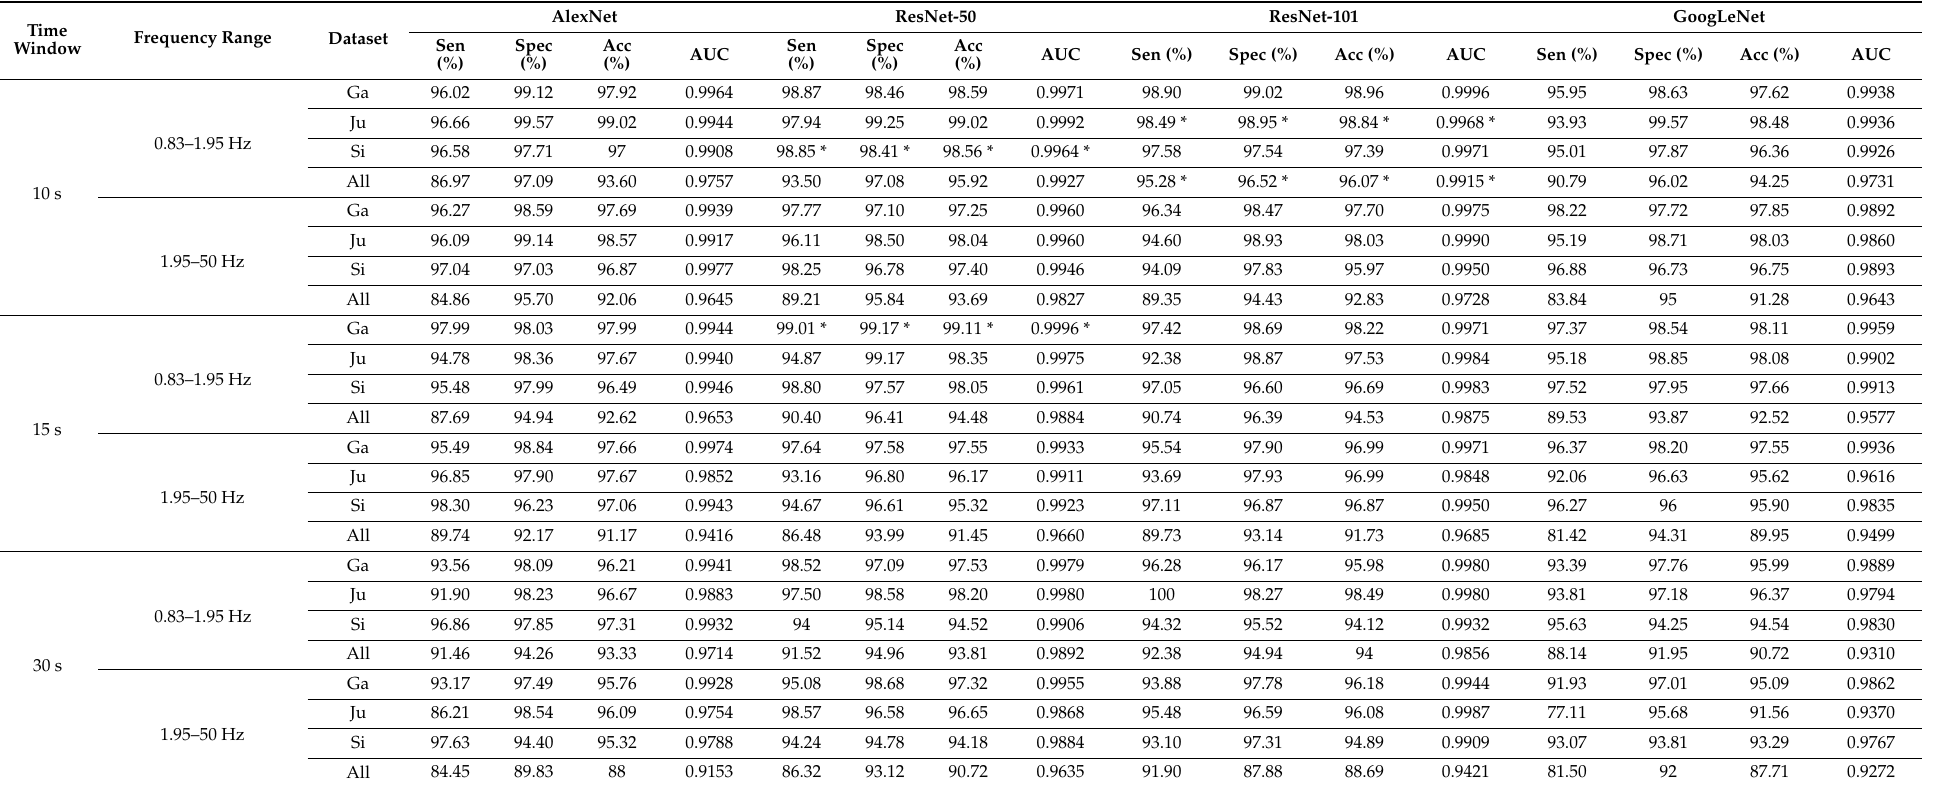
Table 17. Two-class classification of LF for CO and PD (Class 2, Class 2.5, and Class 3) using several CNN classifiers (AlexNet, ResNet-50, ResNet-101, and GoogLeNet) with 10-fold